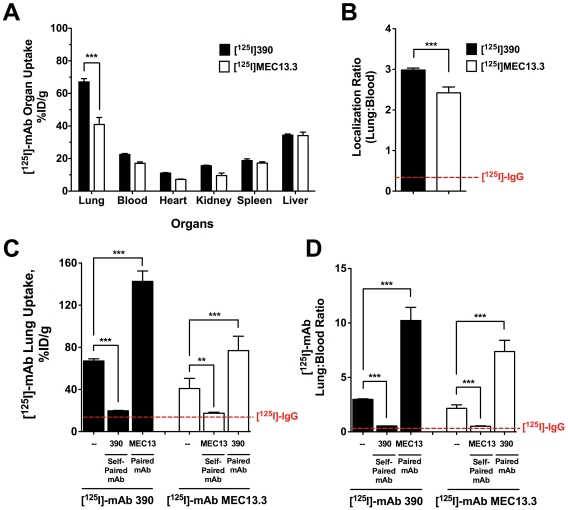

In vivo endothelial targeting of [125I]-mAb to muPECAM-1 is enhanced by paired muPECAM-1 mAb.(A) Biodistribution of anti-muPECAM-1 [125I]-mAbs 390 and MEC13.3 (0.2 µg/mouse) 30 min post-injection. (B) Localization ratio (LR) of [125I]-mAb pulmonary uptake normalized to residual blood radioactivity (lung∶blood), reflecting selectivity of PECAM-1-directed targeting to vascular endothelium. (C) Pulmonary uptake of [125I]-mAb 390 and [125I]-mAb MEC13.3 in inhibited by co-injection of unlabeled self-paired mAb (30 µg/mouse) directed to the same epitope. Co-injection of a paired mAb (30 µg/mouse) enhanced targeting of both [125I]-mAb 390 and [125I]-mAb MEC13.3 by 2.1− and 1.9−fold, respectively. The dashed red line indicates the level of non-specific [125I]-IgG uptake in the lungs. (D) Lung∶blood LR for [125I]-mAb 390/mAb MEC13.3 and [125I]-mAb MEC13.3/mAb 390 pairs increases 3.4−fold. The dotted red line is the LR of [125I]-IgG at 30 min p.i. Data is reported as the mean ± SEM of n = 4–5 animals (***, P<0.001; **, P<0.01).